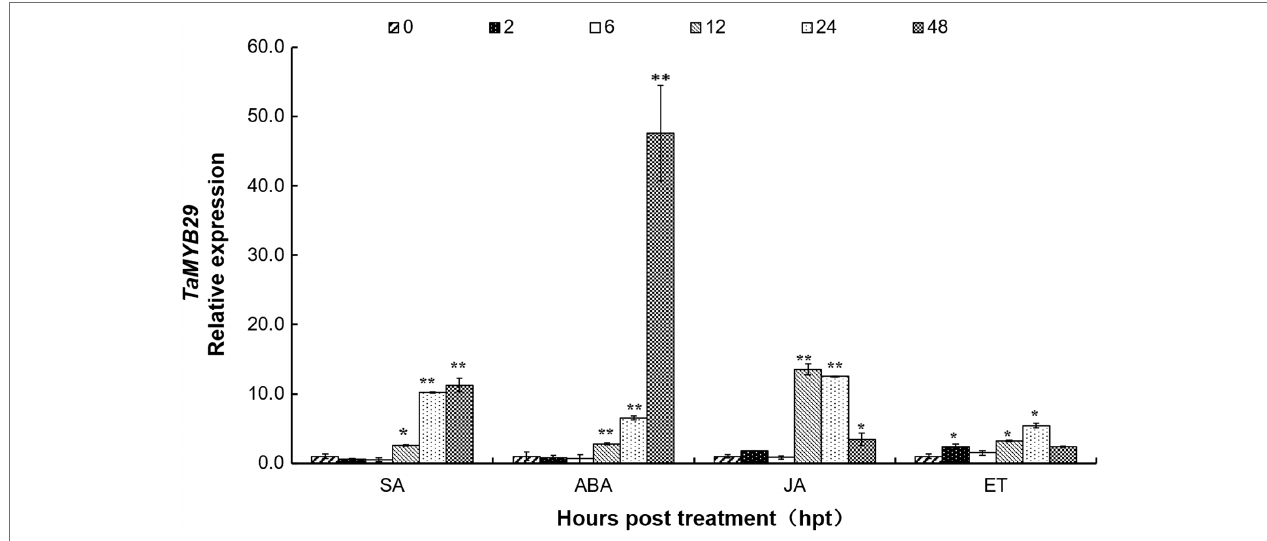
FIGURE 4 | The expression profiles of TaMYB29 in AvS+ Yr10 wheat leaves in response to exogenous hormones. The wheat leaves were sprayed with SA (salicylic acid), ABA (abscisic acid), JA (methyl jasmonate), and ET (ethylene), respectively and were sampled at 0, 2, 6, 12, 24, and 48 h post-treatment (hpt). Three independent biological replications were performed. Error bars represent standard deviation among three biological replications. Student’s t -tests were used for the statistical analyses and the asterisks ( ∗ ) and ( ∗∗ ) indicate a significant difference between that time point and 0 hpt with a value of p < 0.05 and 0.01,